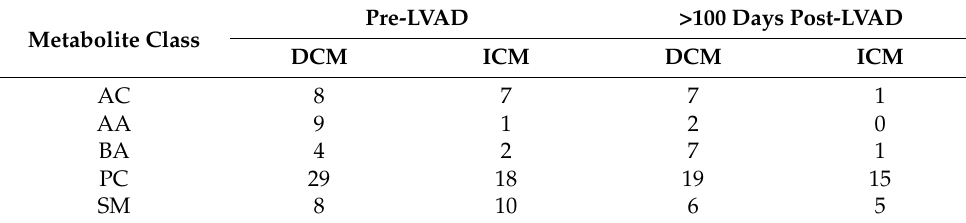
Figure 2. Comparison of metabolic parameters between control and HF. ( A ) Principal component analysis of all patients and control (red) vs. pre-LVAD HF (green), depicting overlapping and dispersing patients with four outliers. ( B ) Heatmap visualization of the 63 significantly altered metabolites between control and HF. Colors indicate the concentration of the respective metabolite. Columns signify samples, and rows metabolites. Table 3. Summarized list of altered metabolites of control vs.